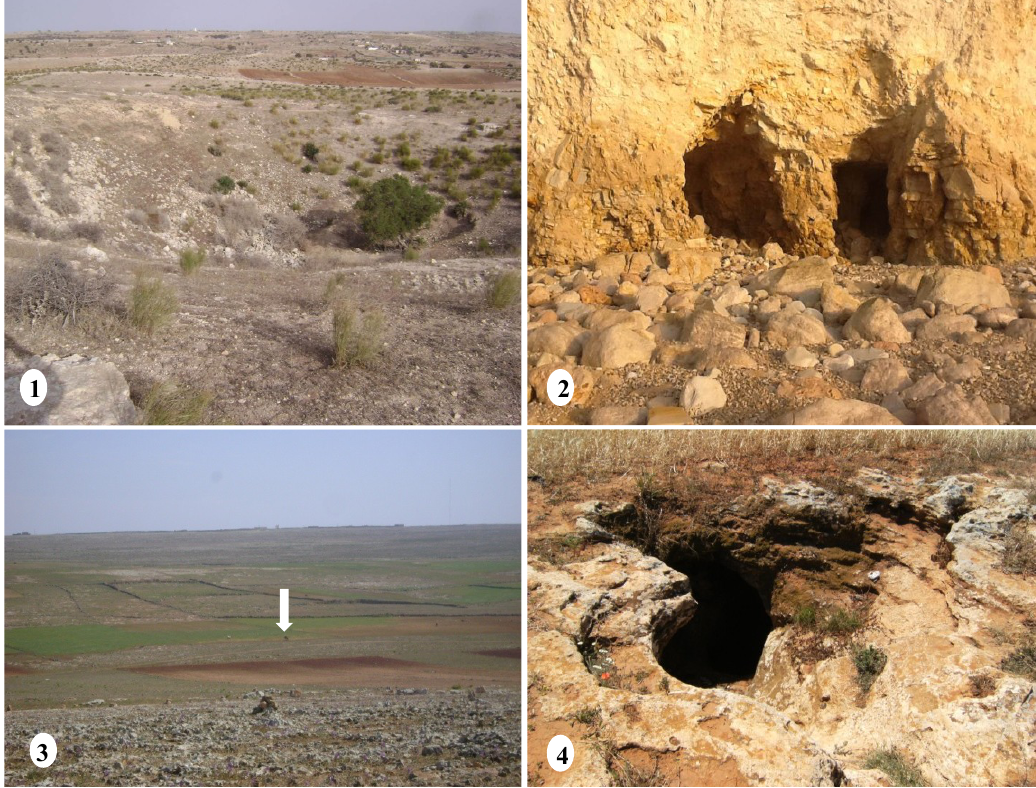
Figure 7. Karst-related caves near Safi (images: Ait Malek, Charif, El Bchari). Karst features in the study area: 1, dolines; 2, a cave in the south of Safi; 3, localization of the cave of Gouraani; 4, a cave of Gouraani north of